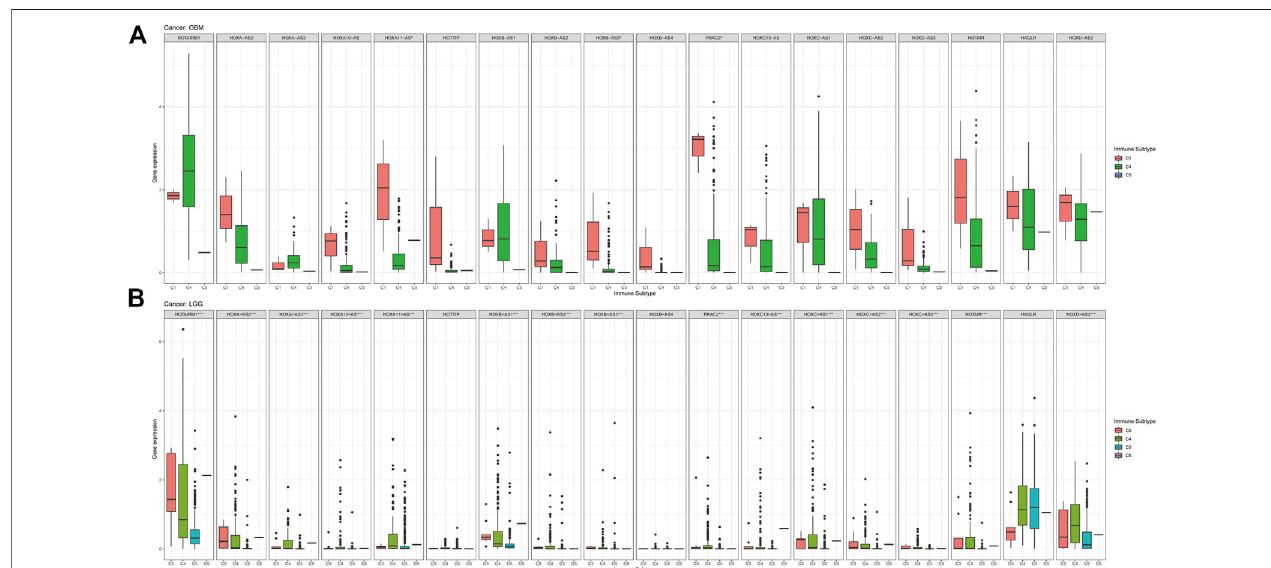
FIGURE 6 | Association of the homeobox antisense transcripts (HOXATs) expression with the tumor immune microenvironment in glioblastoma (GBM) and low- grade glioma (LGG) patients based on TCGA. Association of the HOXATs expression with the immune in fi ltrate subtypes in GBM patients (A) . Association of HOXATs expression with immune in fi ltrate subtypes in LGG patients (B) . C1: wound healing; C2: INF-r dominant; C3: in fl ammatory; C4: lymphocyte depleted; C5: immunologically quiet; C6: TGF β dominant,* p < 0.05, ** p < 0.01, *** p <